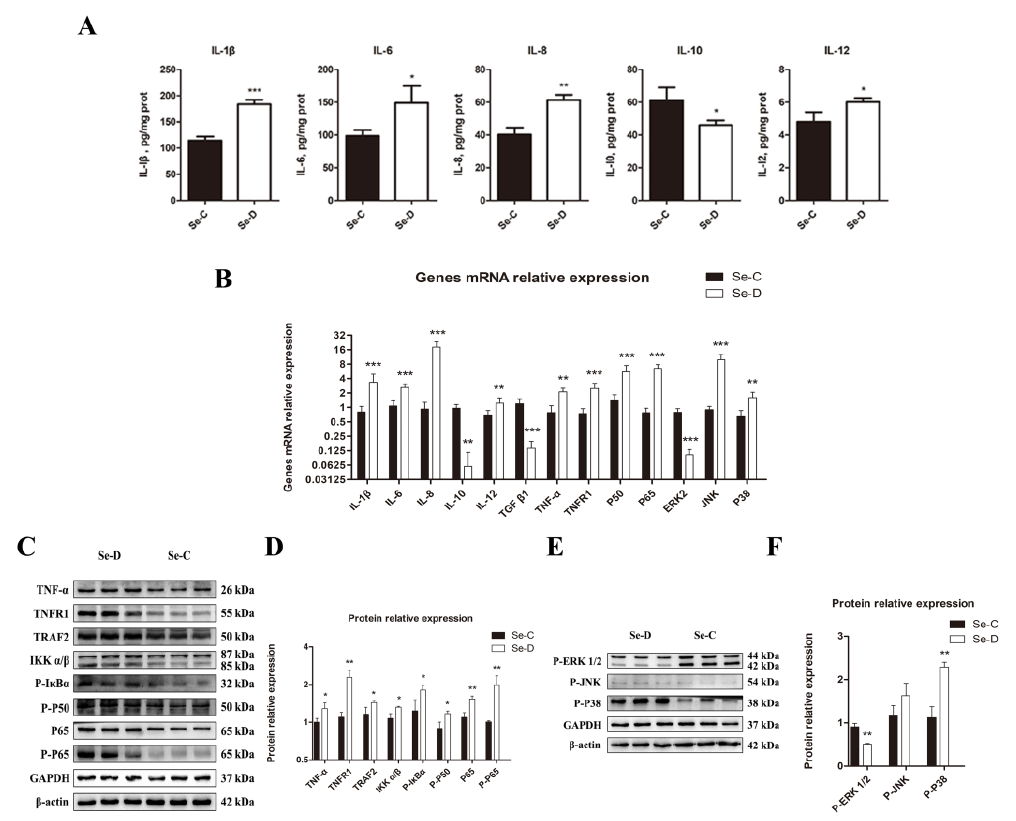
Figure 5. Inflammatory factor levels ( A ) in the lungs of calves were detected by ELISA. ( B ) Expression levels of cytokines, NF- κ B, and MAPK pathway related genes. The levels of NF- κ B ( C , D ) and MAPK ( E , F ) pathways related proteins are detected and their quantification. The mean ± SD is used to present the data above, n = 5 calves per group (except for WB n = 3). * p < 0.05, ** p < 0.01, *** p < 0.001.